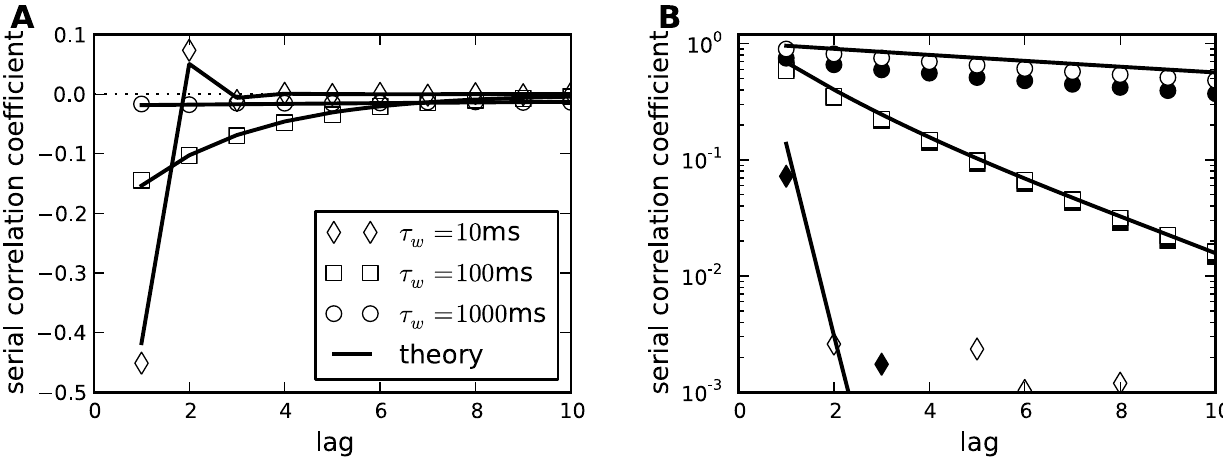
(cid:3) ms for th